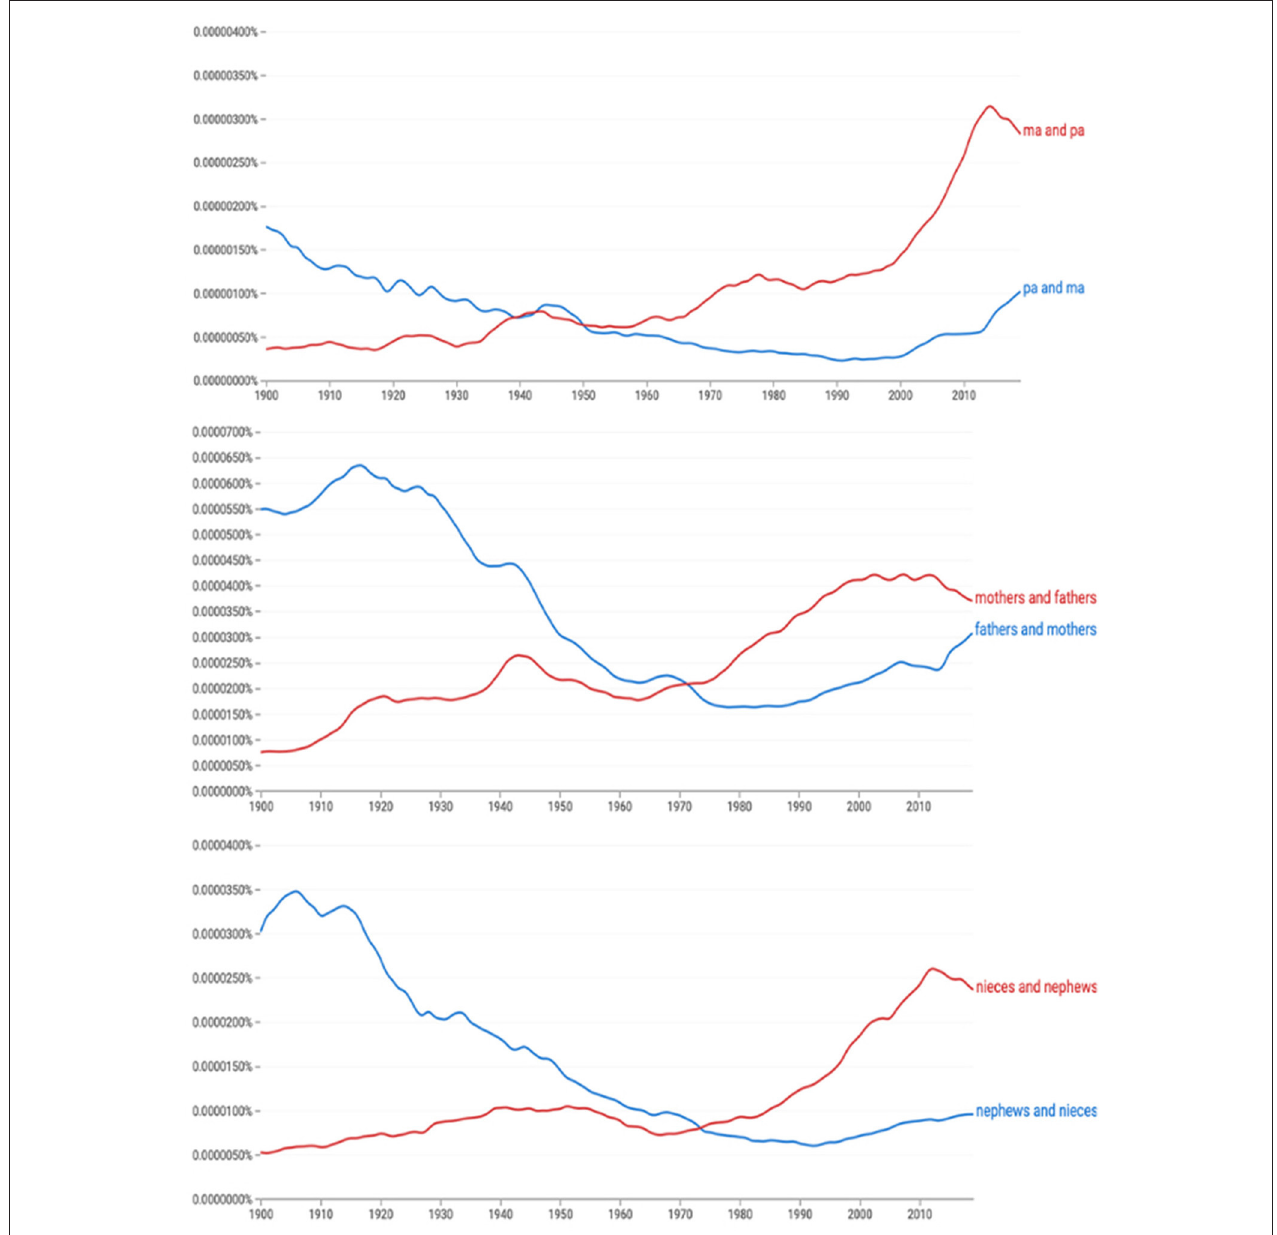
FIGURE 1 | The historical shifts in preferred order from pa and ma to ma and pa (top) , from fathers and mothers to mothers and fathers (middle) , and from nephews and nieces to nieces and nephews (bottom) in Google Books N-gram (Michel et al., 2011). The x-axes represent time 1900–2019 and the y-axes represents the relative percentages of each order. Female-first order is represented in red and male-first in blue.